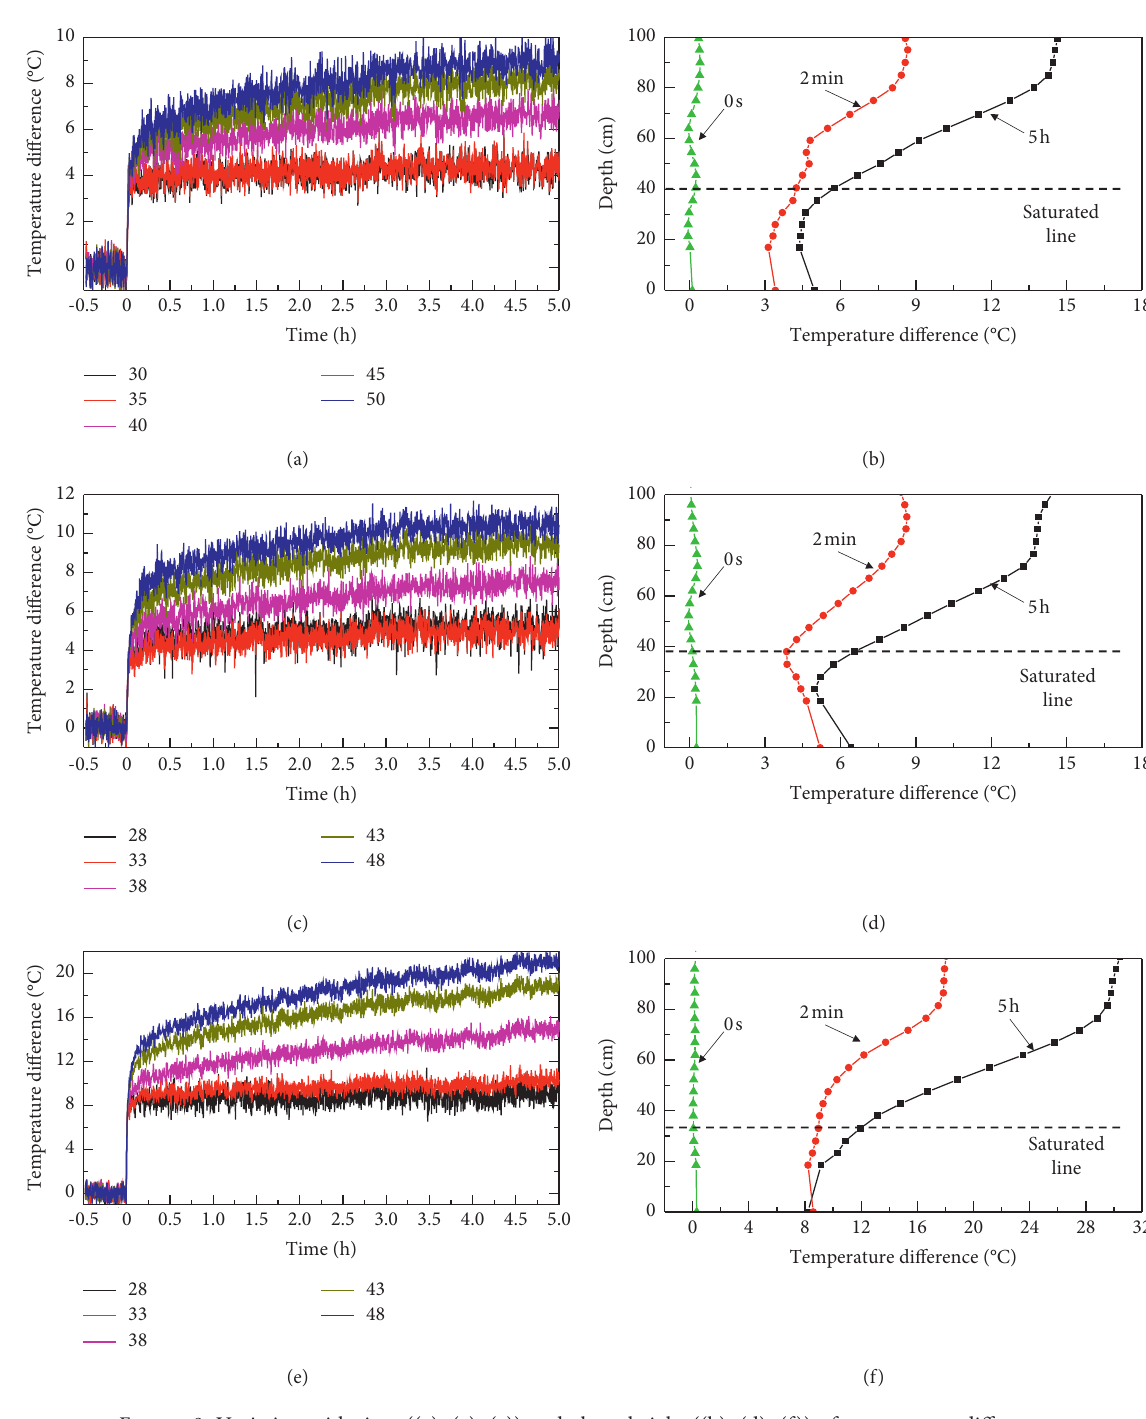
Figure 8: Variation with time ((a); (c); (e)) and along height ((b); (d); (f)) of temperature